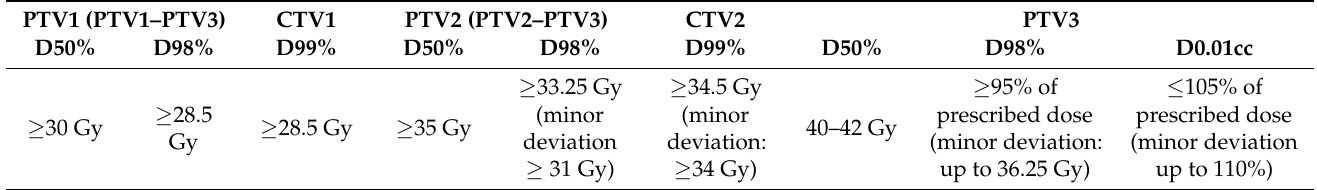
Table 2. Prescription doses of the target volumes (PTVs) for stereotactic body radiotherapy (experimental arm). PTV1 (PTV1–PTV3) CTV1 PTV2 (PTV2–PTV3)